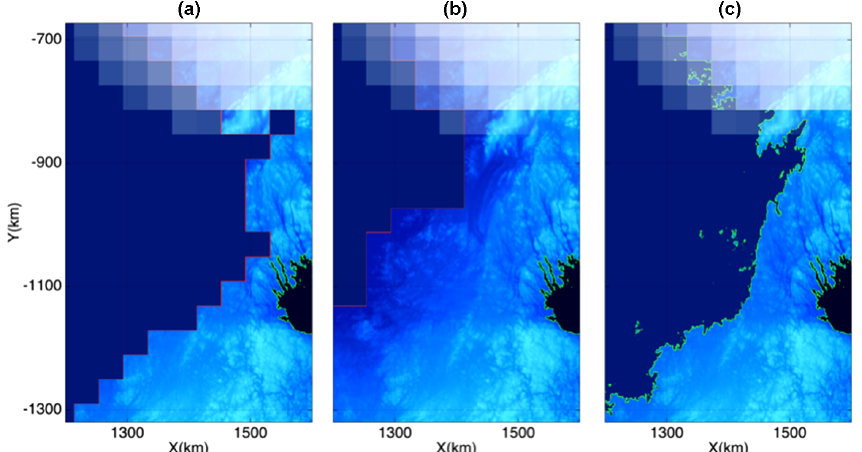
Figure 6. The area around the eastern shore of the lake, outlined in red in Fig. 5. (a) The 40km resolution estimate. (b) The result of the 40km maximum topography fill to a water depth 20% below that of the 40km estimate. (c) The final 1km lake. Note that the algorithm allows for ice to float when the water column is high enough, creating a small ice shelf along the margin, visible in (c) where part of the lake’s shoreline runs beneath the